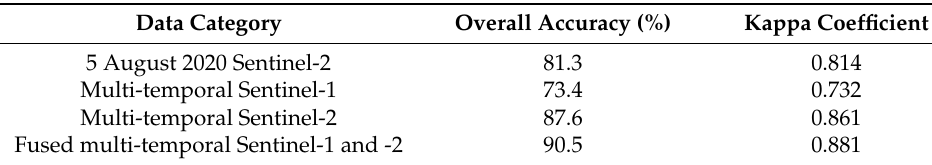
Table 6. Results of accuracy